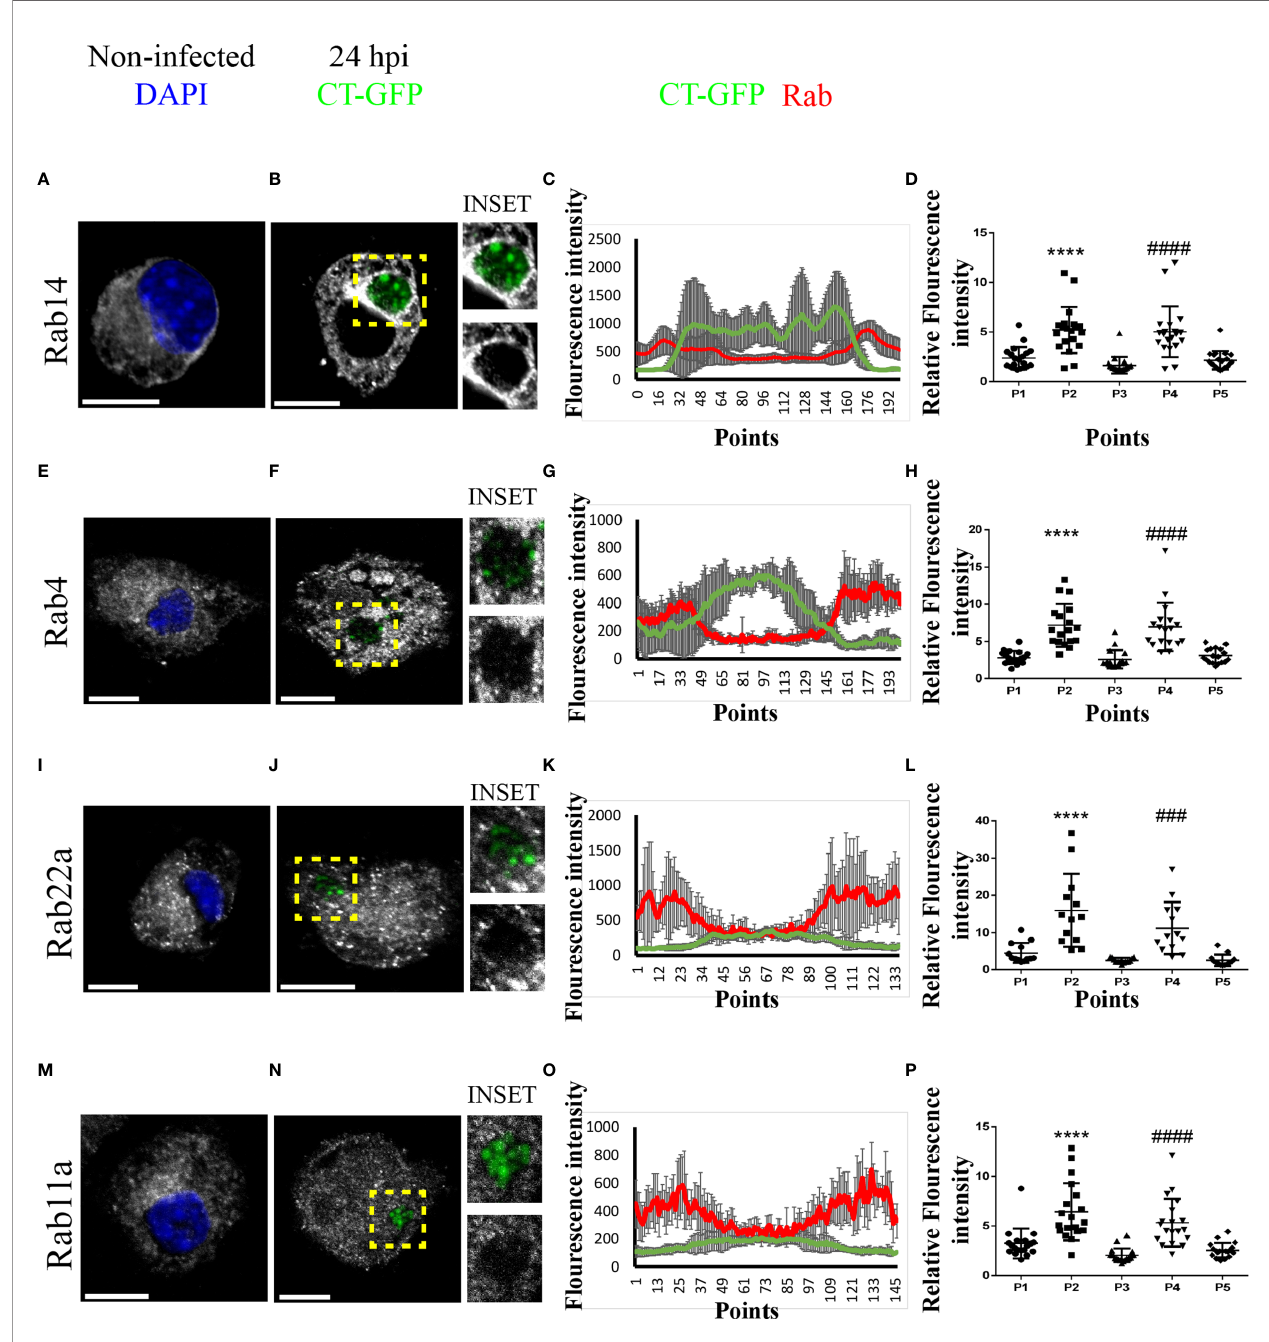
FIGURE 3 | C. trachomatis recruits Rab14, Rab4, Rab22a, and Rab11a to the inclusion in JAWS-II DCs. JAWS-II DCs were infected with GFP- C. trachomatis L2 at MOI 100 for 24 h and analyzed by confocal microscopy. The intracellular distribution of (A, B) Rab14, (E, F) Rab4, (I, J) Rab22a and (M, N) Rab11a was evaluated in non-infected and infected cells. Endogenous Rab proteins were detected by indirect immuno fl uorescence using primary antibodies followed by its corresponding Cy3-conjugated secondary antibodies. Insets show a chlamydial inclusion magni fi cation for each marker. DAPI was used to stain DNA. Bars represent 10 um. Images are representative of three independent experiments and more than 20 images were analyzed for each Rab. (C, G, K, O) A representative chlamydial inclusion was transversely crossed with eight diameter lines to obtain an intensity histogram. Line graphs show the MFI from GFP and the corresponding Rab protein with the SD for each point. (D, H, L, P) Chlamydial inclusion was transversely crossed with a diameter line to obtain an intensity histogram for each Rab protein; and fi ve points of each line corresponding to the cytoplasm (P1), inclusion membrane (P2), inside the inclusion (P3), inclusion membrane (P4), and cytoplasm (P5) were selected. Twenty (20) cells were analyzed for each Rab protein. One-way ANOVA with Dunnett ’ s multiple comparison post-test were performed. ### P < 0.001, #### P < 0.0001, and ****P <